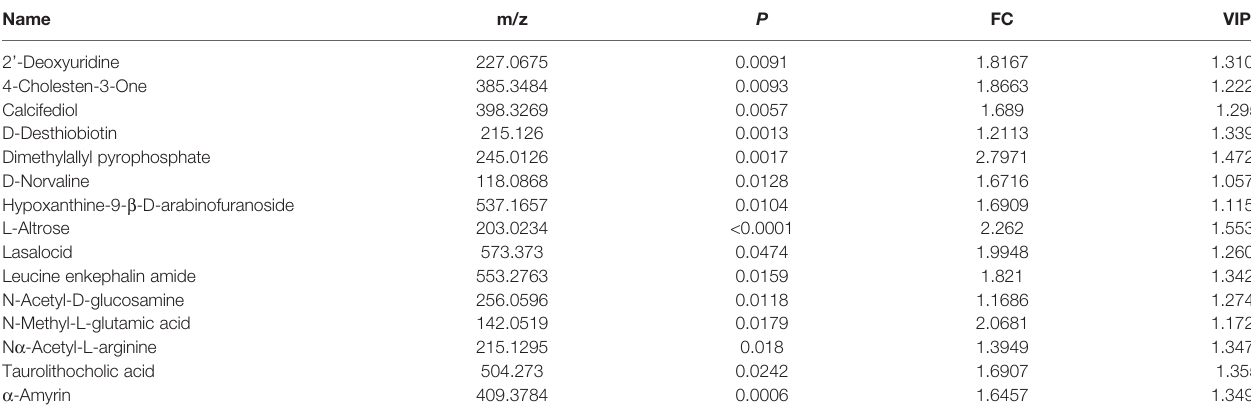
*This table didn ’ t list fi ve exogenous compounds, namely, dihydrocapsaicin, benzoic acid, Apramycin, sulfa quinazoline (sulfaquinaoxaline),